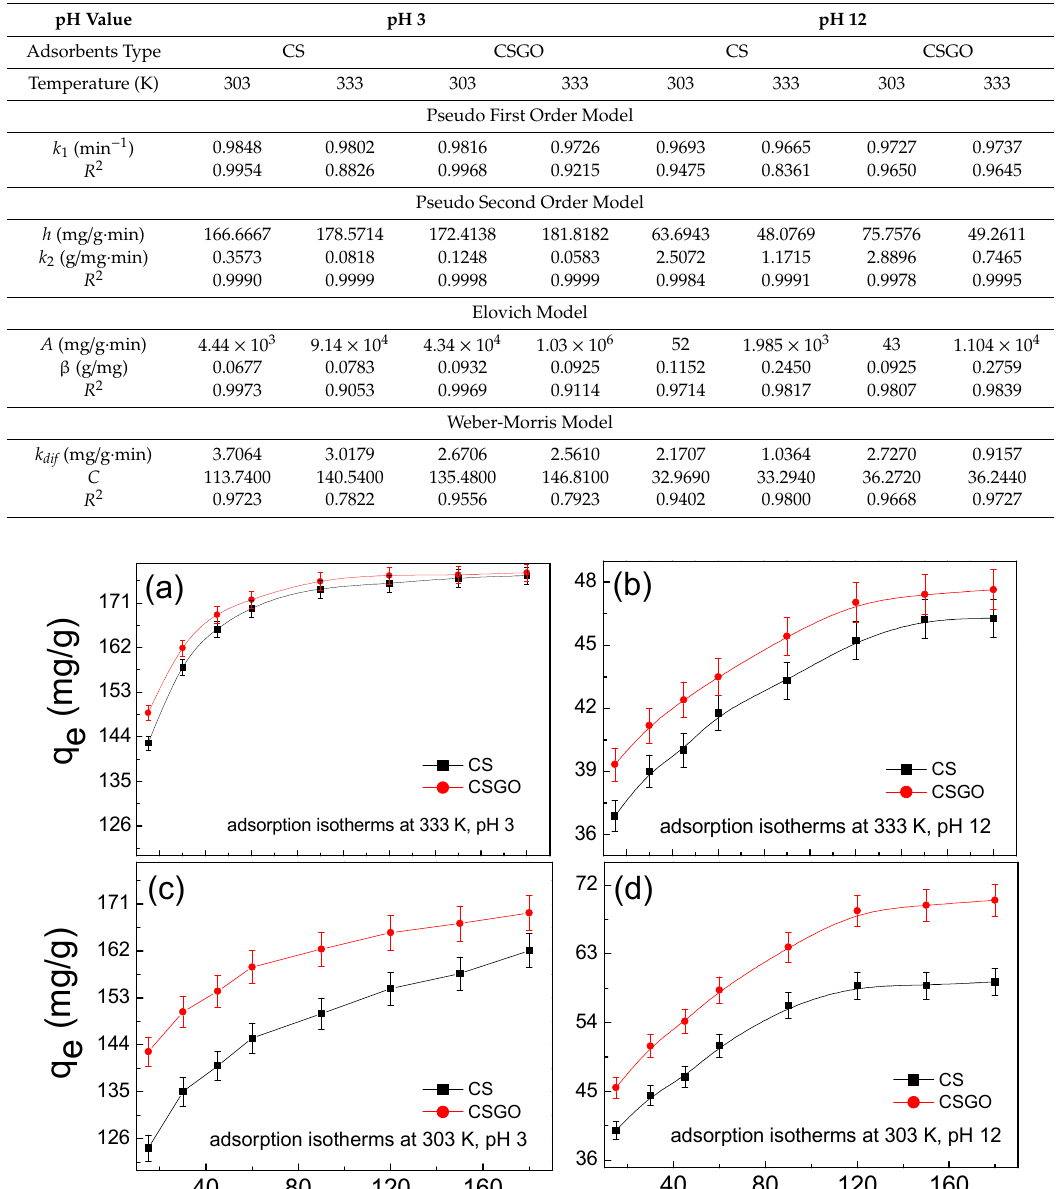
Table 3. Di ff erent adsorption kinetics models for the adsorption of RB221 by the di ff erent adsorbents.